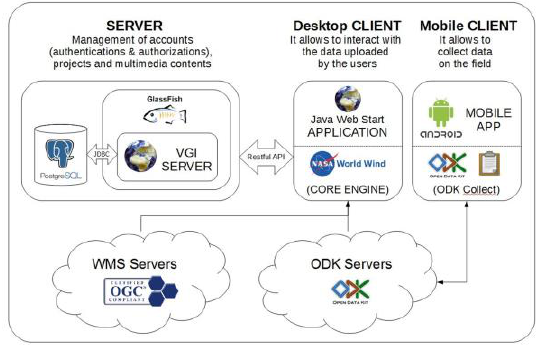
Figure 1. System architecture of PoliCrowd